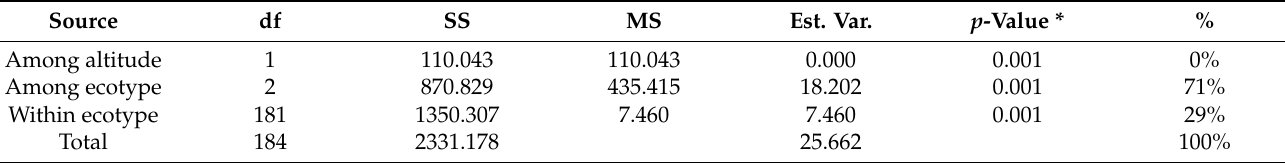
Table 4. Analysis of molecular variance (AMOVA) among thirty-seven purple rice landraces in northern Thailand. Source df